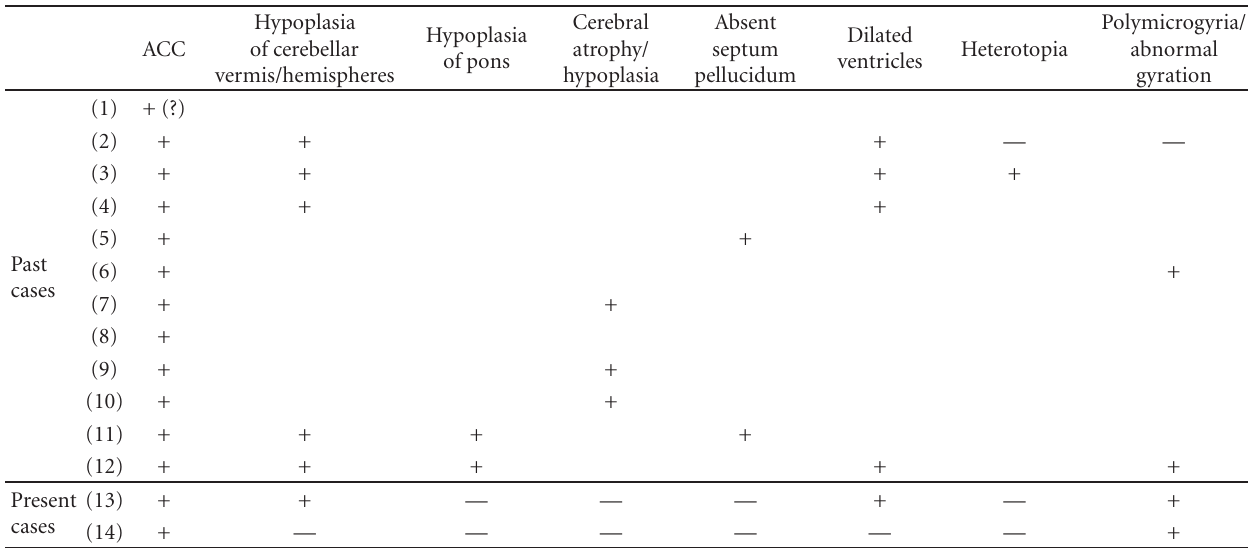
Table 2: MRI findings in patients with Vici